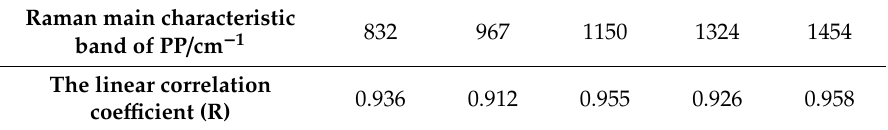
Table 2. The linear correlation coe ffi cient between the Raman intensity of the PP main characteristic band and the degree of